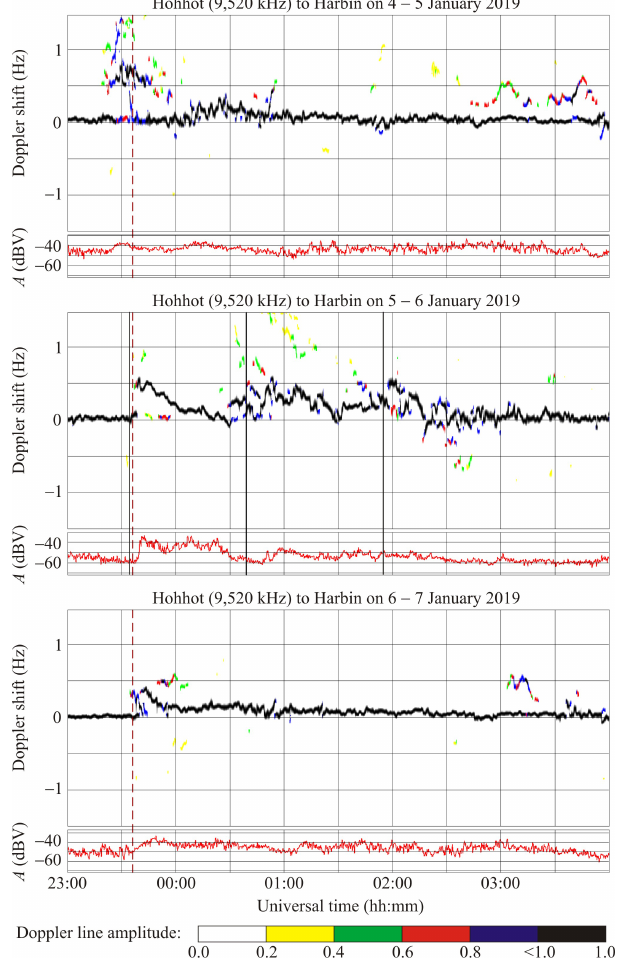
Figure 8. The same as in Fig. 4 but for the Hohhot to Harbin radio- wave propagation